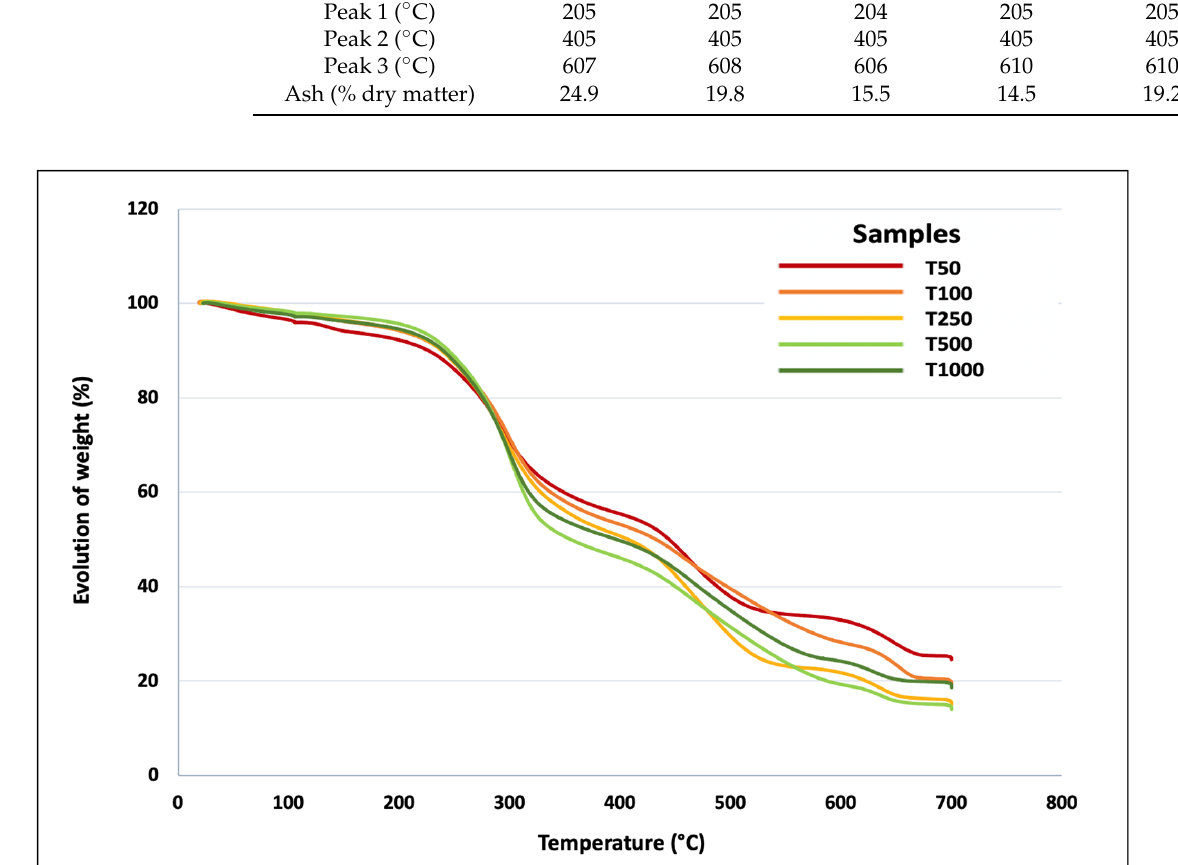
Figure 3. Thermal behavior of the different fractions of tomato particles.